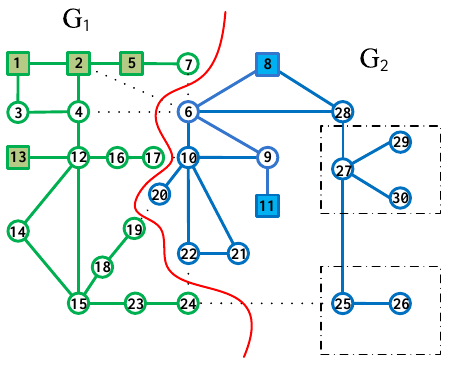
(1) and G (1) are marked in bold. 1 2